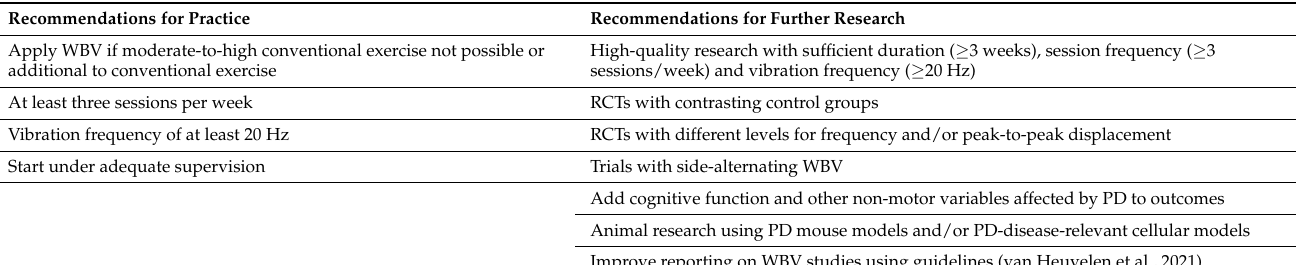
Table 5. Recommendations for practice and further research of WBV in relation to